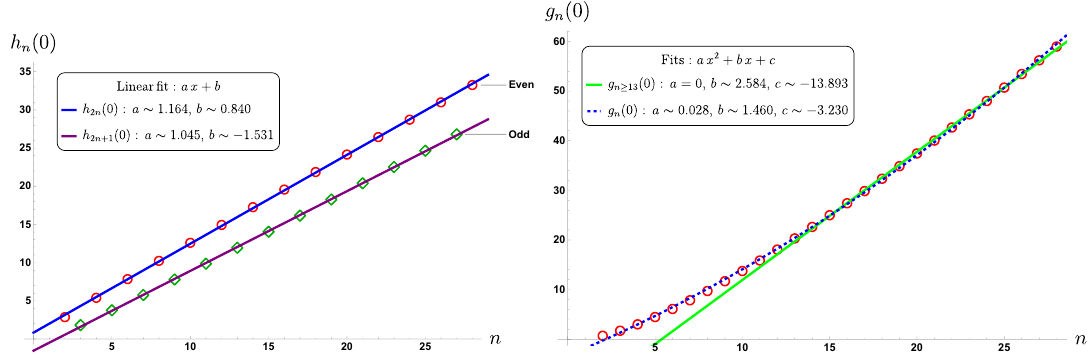
Figure 6 . Fits to h n (0) and g n (0) as a function of n . Note that, for g n (0) the solid line is a linear fit ( a = 0 ) that omits the first 12